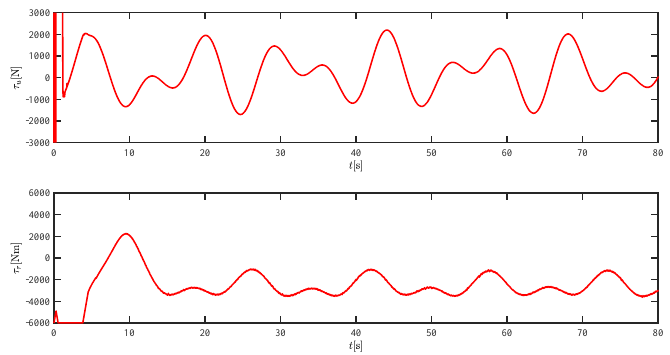
Figure 14. The lumped disturbances and their estimations at fast speed.